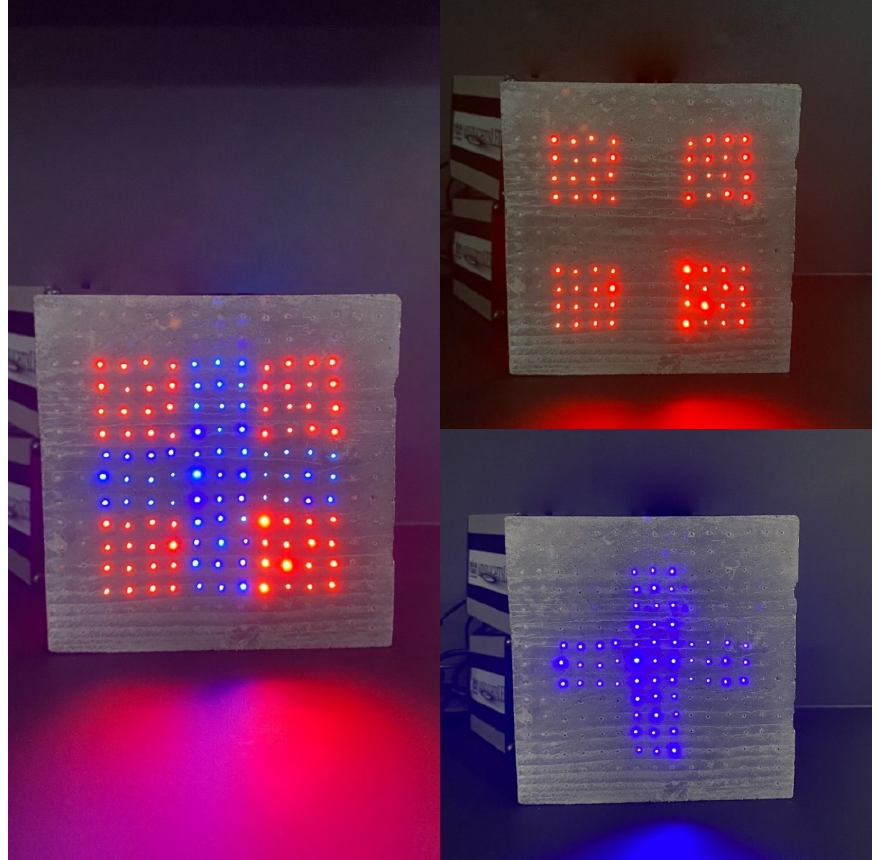
Figure 21. Examples of applications and lighting of light-permeable concrete slabs.